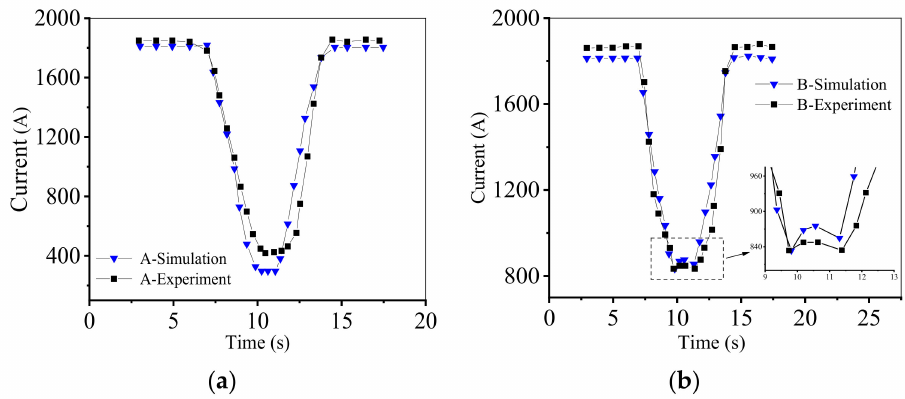
Figure 9. The change law of the branch current of the brush plate vs. time during cleaning. ( a ) A-brush plate. ( b ) B-brush